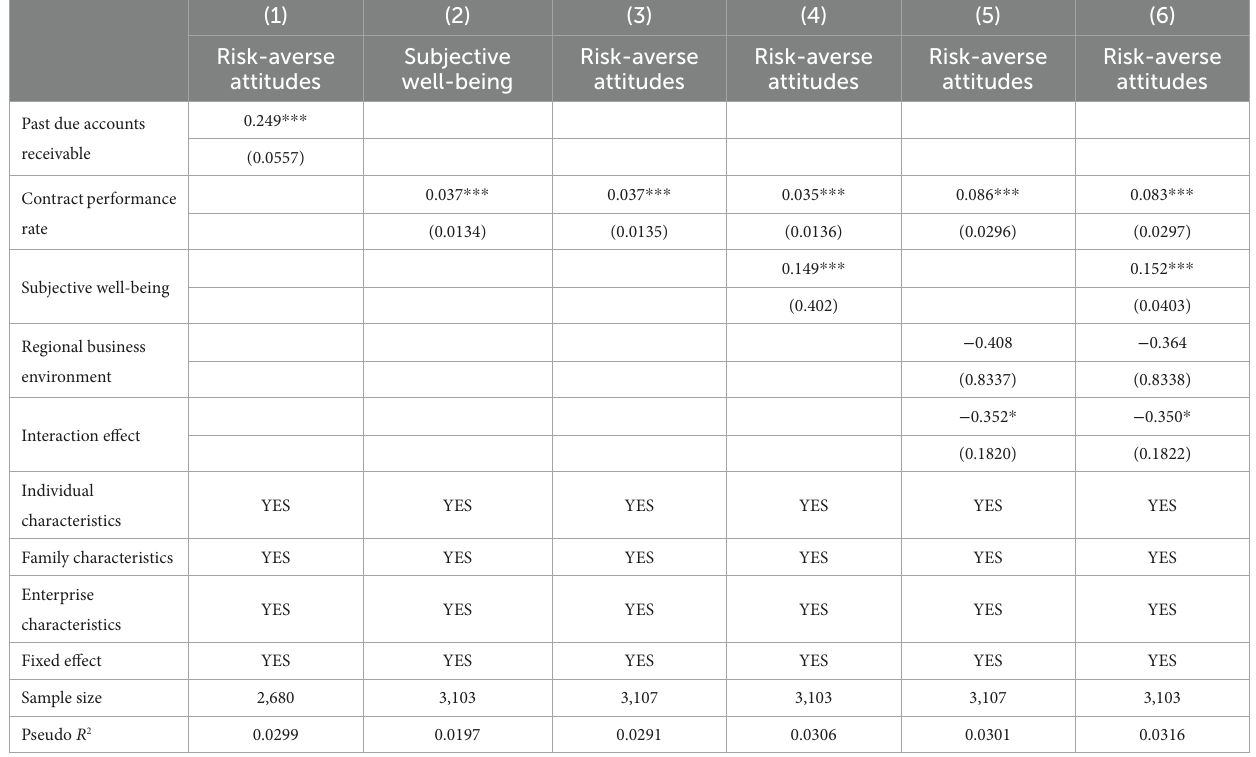
TABLE 7 Robustness test